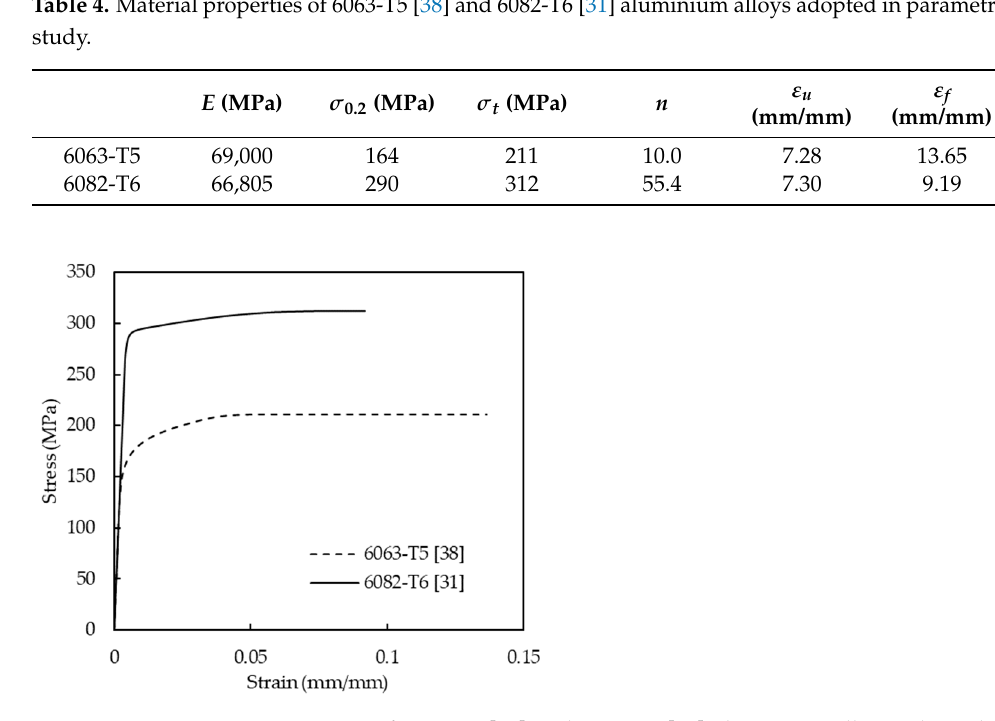
Figure 4. Stress-strain responses of 6063-T5 [38] and 6082-T6 [31] aluminium alloys adopted in parametric study.